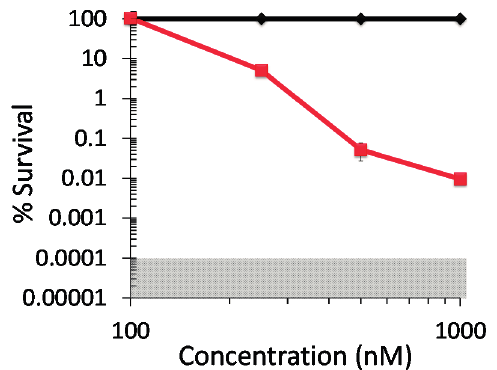
Figure 4. Photodynamic inactivation of Mycobacterium smegmatis mc 2 155 ATCC-700084 as a function of DIMPy-BODIPY concentration. Displayed is the % survival of the dark control ( ♦ ) and the light treated samples ( ■ ). Illumination and assay conditions were as in Figure